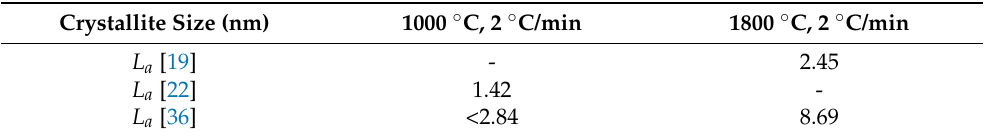
Table 4. L a obtained using the 532 nm excitation wavelength.